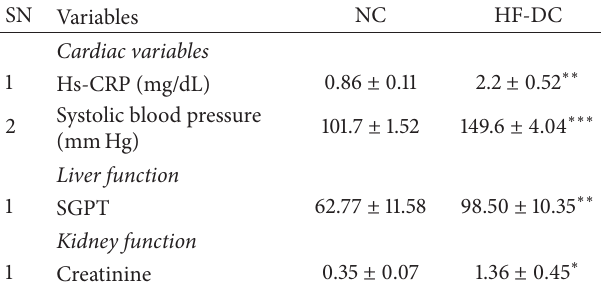
Table 3: Study variables in the experimental groups.